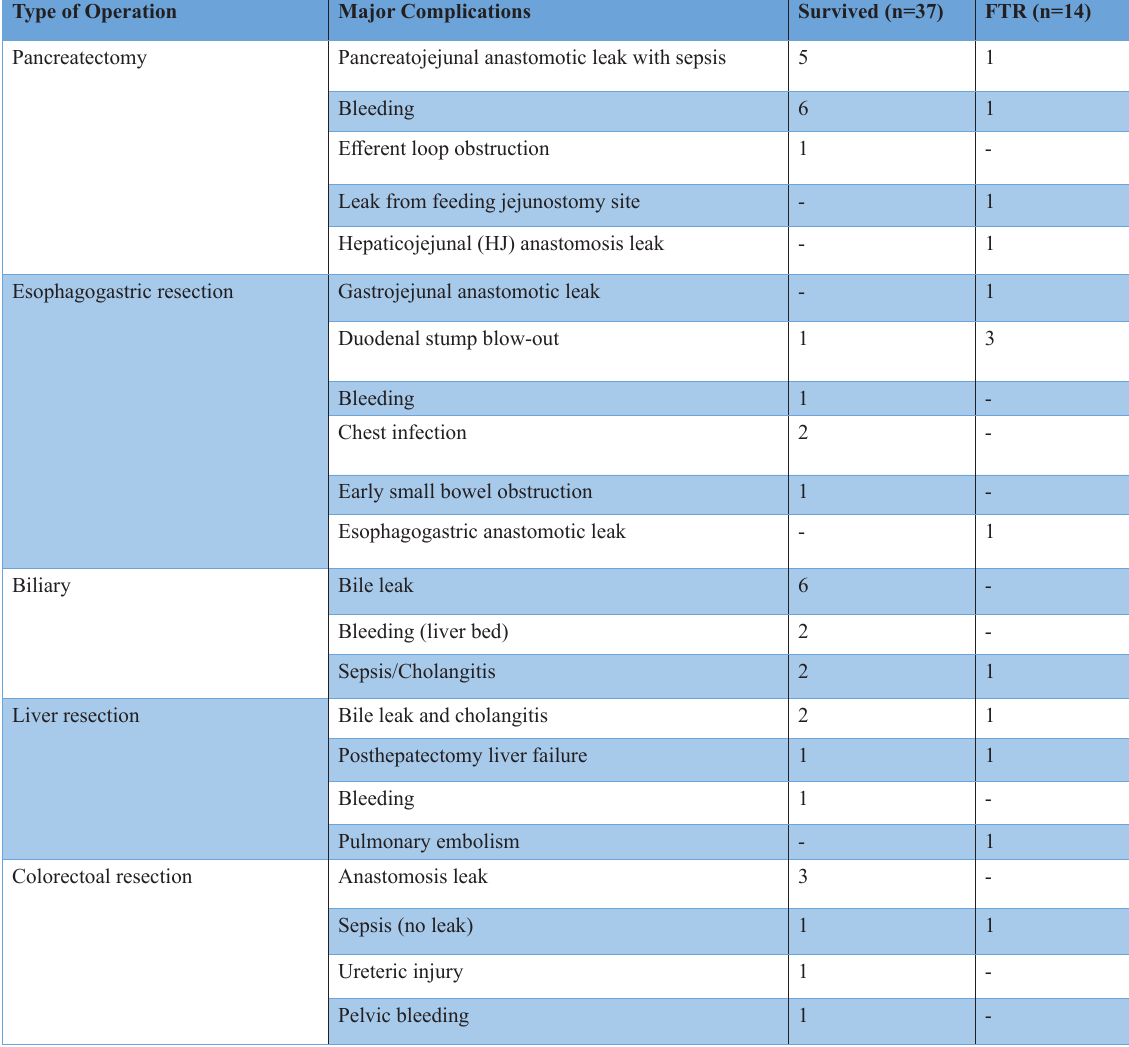
Table 1. Postoperative major complication in details in patients who survived and with Failure to rescue (FTR)